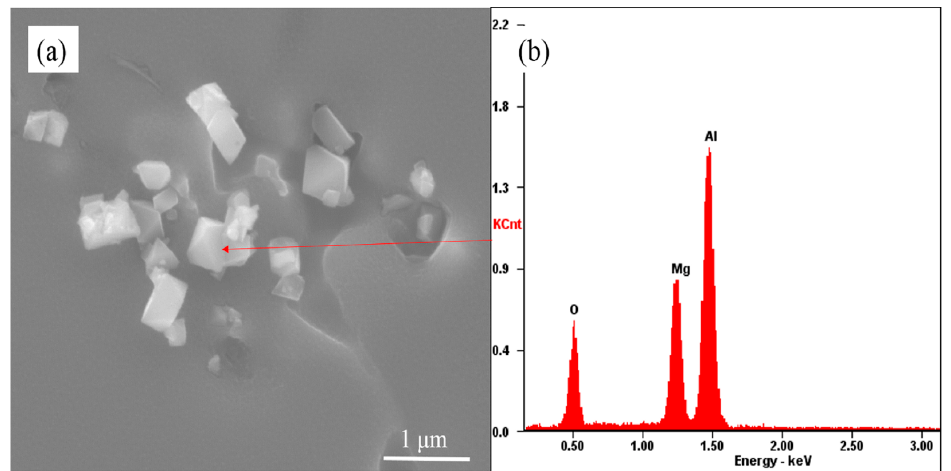
Figure 11. ( a )The micro-morphology of 5083 alloy scraps after being held in the commercial pure aluminum melt for 30 min; ( b ) Corresponding EDS results.